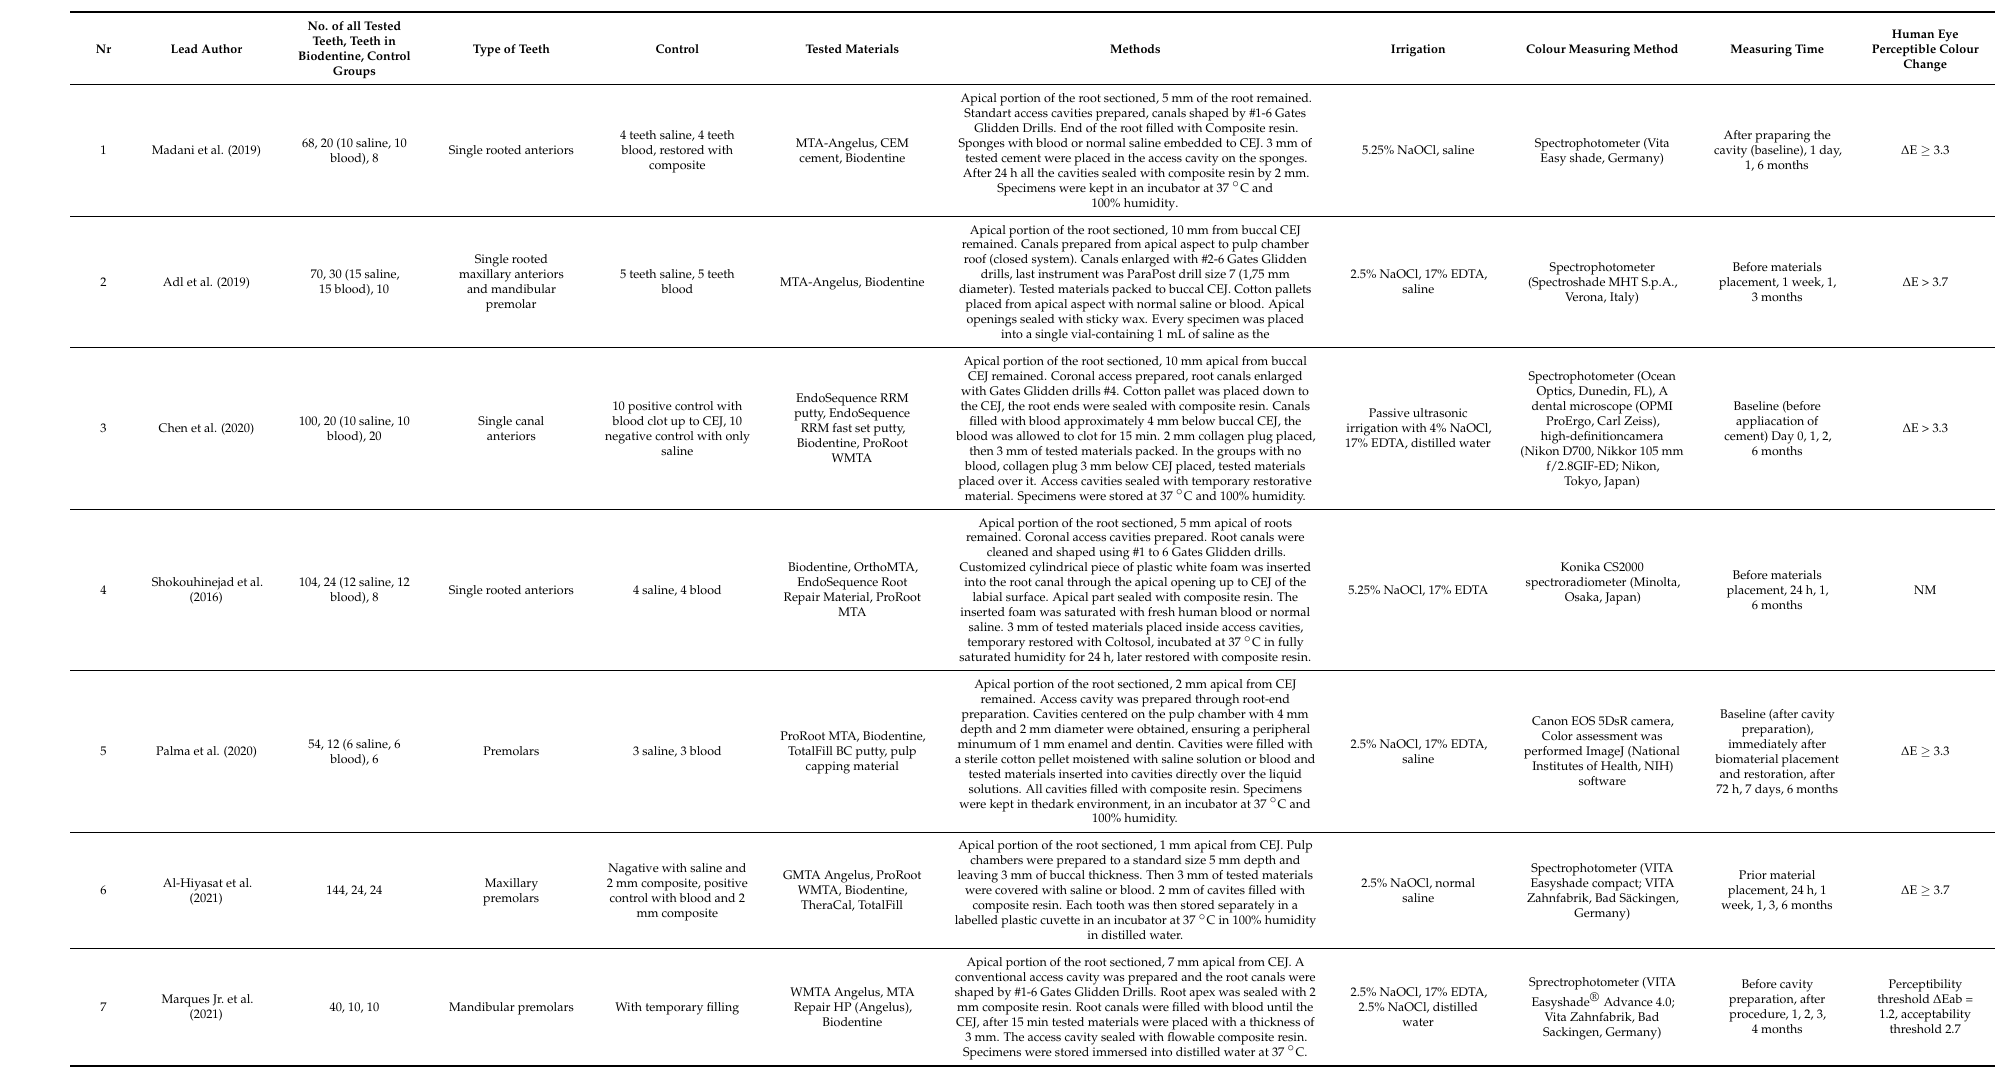
Table 1. Extracted from the Included